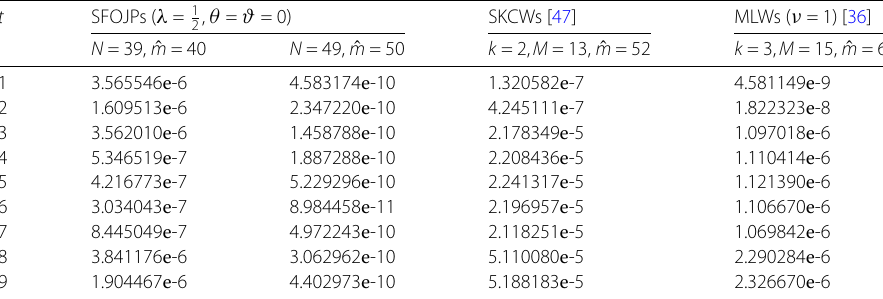
Table 3 Absolute errors at the interval [0,10), for Example